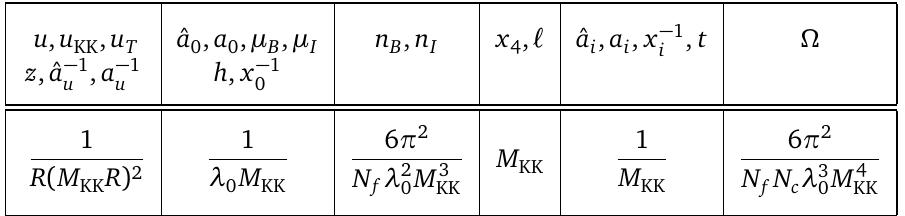
Table 1: Factors that relate the dimensionless quantities in the first row to their di- mensionful counterparts, for instance u = U / [ R ( M